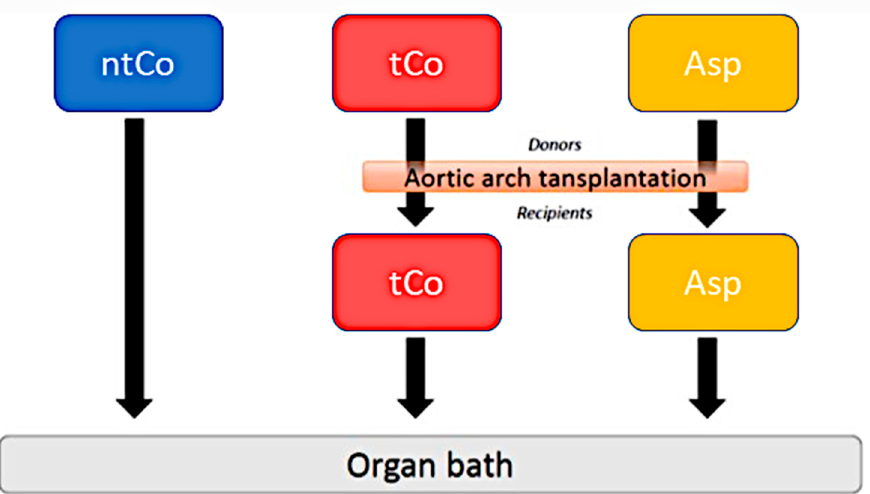
Figure 1. The applied experimental design. tCo: transplanted control group; Asp: Aspirin group; ntCo: non-transplanted control group.